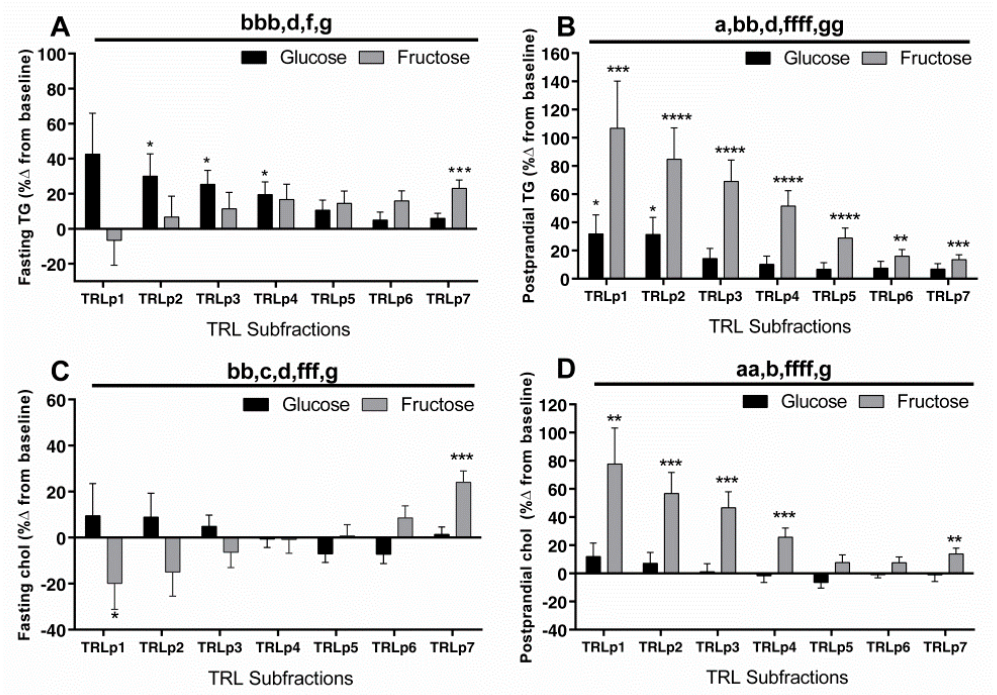
Figure 3. Percent (%) changes (10 weeks vs. 0 weeks) of fasting ( A ) and postprandial ( B ) TG and fasting ( C ) and postprandial ( D ) chol in TRL subfractions (chylomicrons (CM) and very low density lipoprotein (VLDL)) in subjects consuming glucose ‐ ( n = 15) or fructose ‐ sweetened beverages ( n = 16) for 10 weeks. a p < 0.05, aa p < 0.01, effect of sugar; b p < 0.05, bb p < 0.01, bbb p < 0.001, effect of particle size, c p < 0.05, effect of gender, d p < 0.05, effect of sugar x size; f p < 0.05, fff p < 0.00, ffff p < 0.0001 for fructose ‐ induced lineal trend, g p < 0.05, gg p < 0.01 for glucose ‐ induced lineal trend. * p < 0.05, ** p < 0.01, *** p < 0.001, **** p < 0.0001, LS means different from zero—within ‐ group change from baseline. Data shown as mean ± SEM. Note the differences in scales.